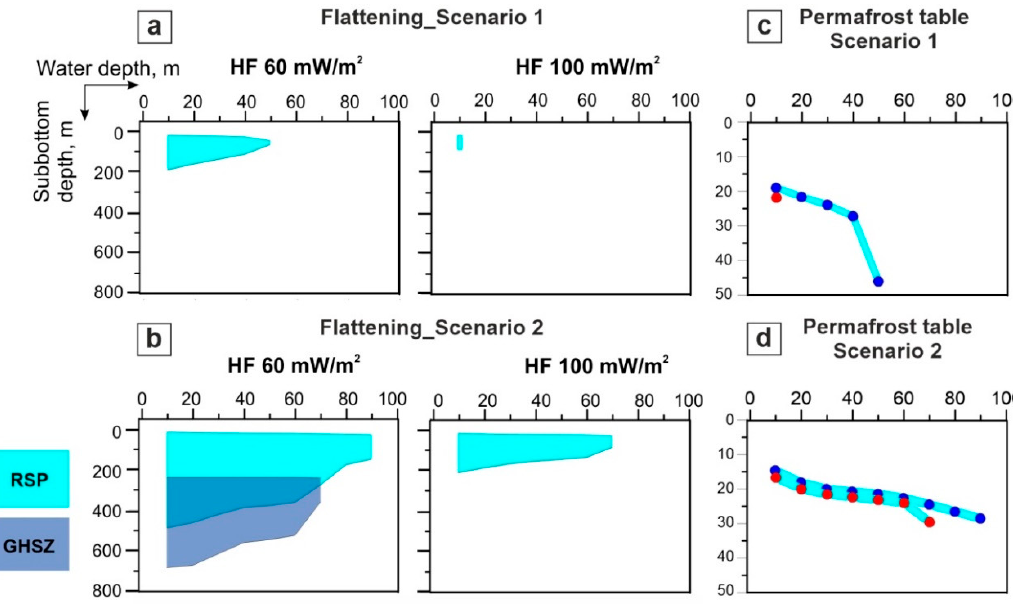
Figure 4. ( a , b ) Areal distribution and thickness of RSP simulated under Scenario 1 ( a ) and Scenario 2 ( b ), and ( c ) distribution and thickness of GHSZ under Scenario 2 at a constant HF of 60 mW / m 2 .